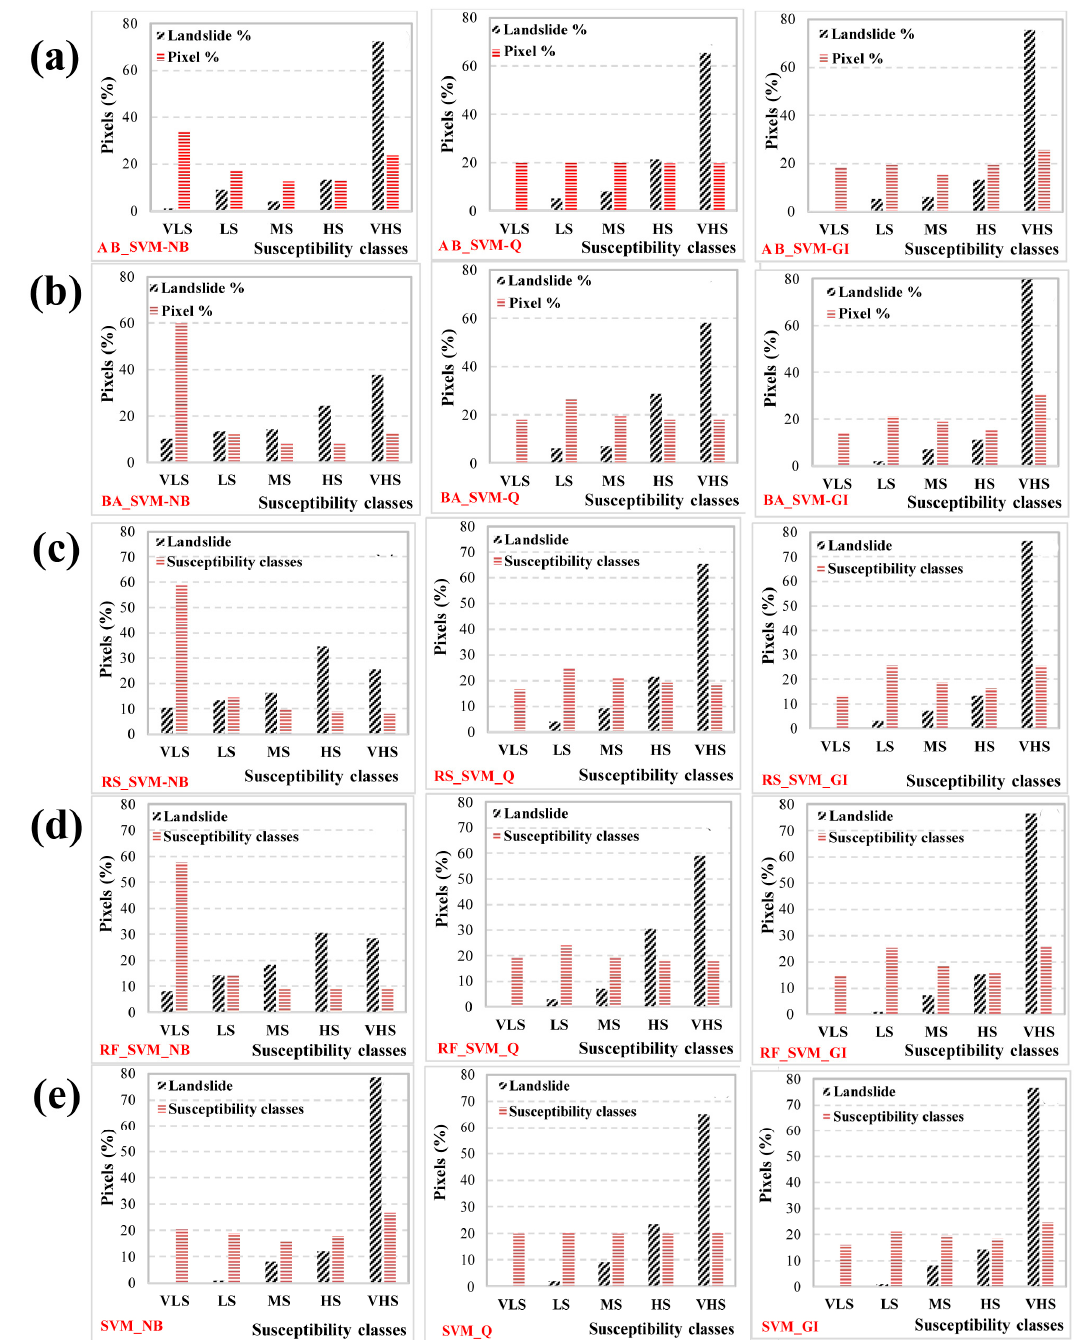
Figure 7. Histogram classification for all models: ( a ) AB-SVM ensemble model; ( b ) BA-SVM ensemble model; ( c ) RS-SVM ensemble model; ( d ) RF-SVM ensemble model, and ( e ) SVM base classifier; NB (Natural Breaks); Q (Quantile); GI (Geometric